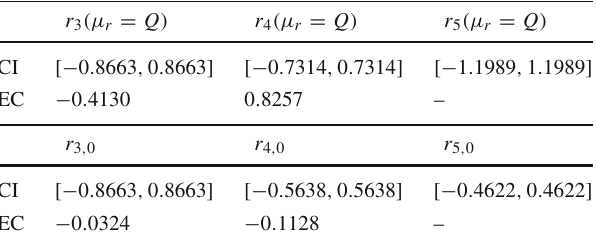
Table 3 The predicted smallest 95 . 5% credible intervals (CI) for the scale-dependent conventional coefficients r i (μ r ) ( i = 3 , 4 , 5) at the scale μ r = Q and the scale-invariant coefficients r i , 0 ( i = 3 , 4 , 5 ) of R n ( Q = 31 . 6 GeV ) via the Bayesian-based approach. The exact values